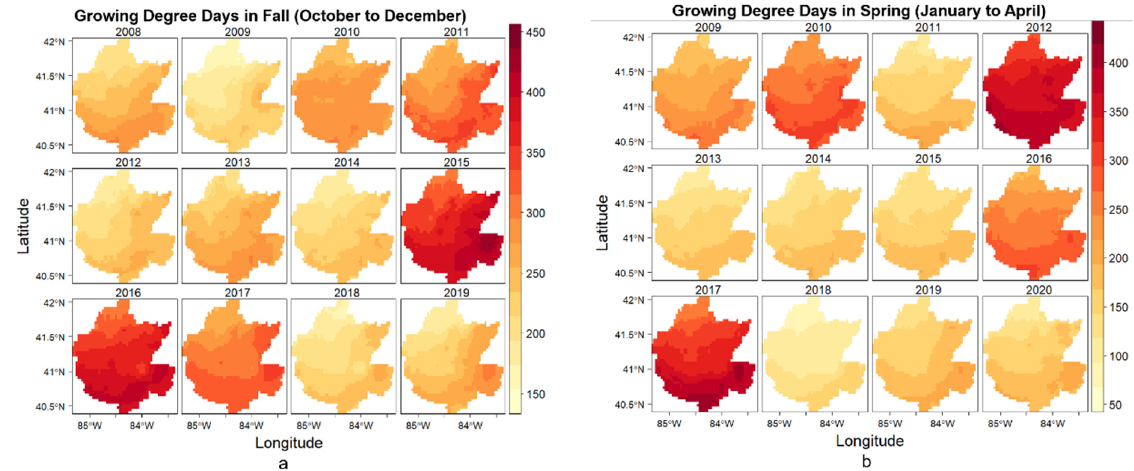
Figure 8. Fall ( a ) and spring ( b ) GDD calculated for the MRW using PRISM daily temperature data at 4 km spatial resolution. The years indicated in this figure correspond to the fall months of a given year.